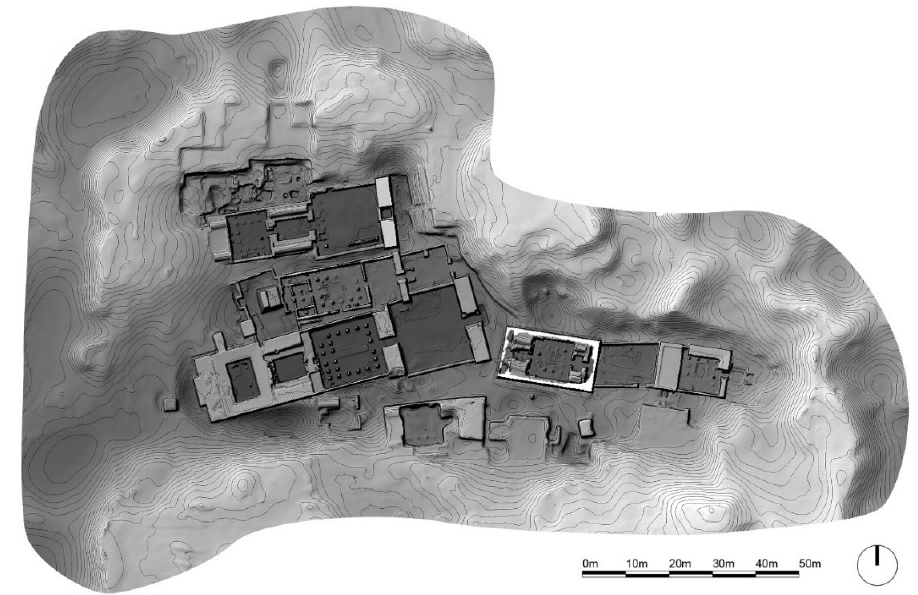
Figure 7. Elevation map of the concession of the Dutch-Italian mission to Saqqara, including the excavation area.